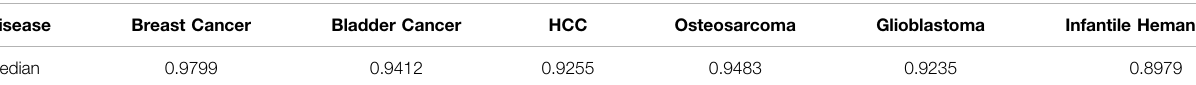
Frontiers in Genetics |